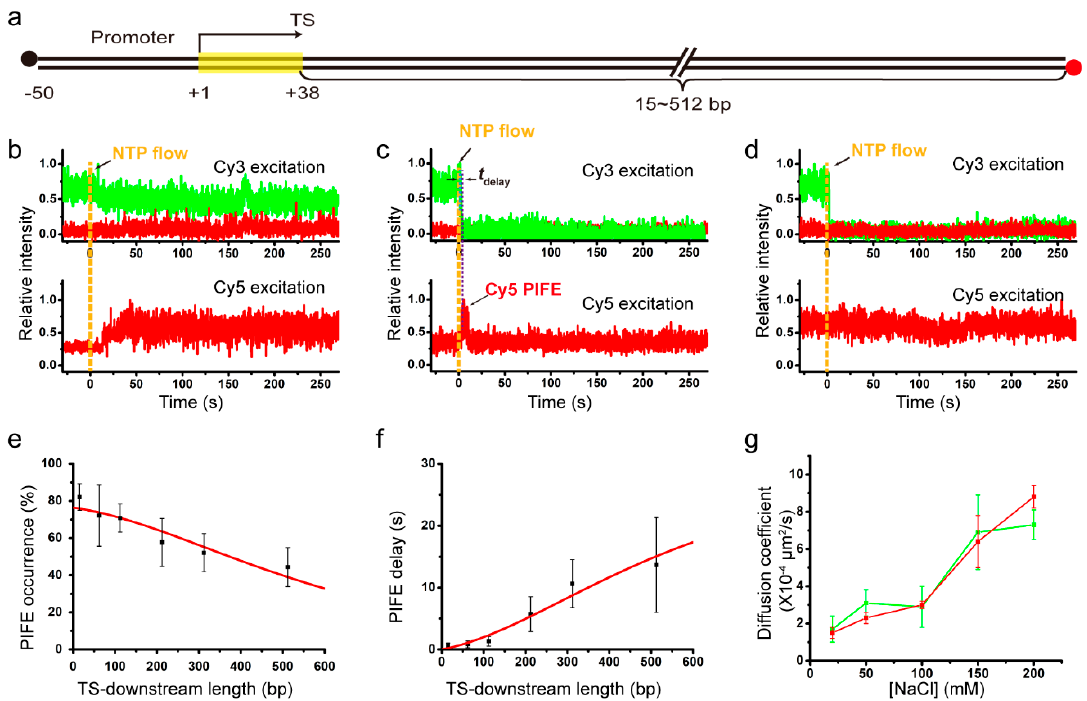
Figure 2. ( a ) DNA with varying length of TS-downstream part. Template DNAs were labeled with Cy5 at the downstream end and immobilized using biotin (black) at the upstream end. Transcript RNAs were nascently labeled with Cy3 at the 5’ end. ( b – d ) Representative fluorescence traces were taken from complexes with DNA template L+212. The Cy3 (green) and Cy5 (red) signals were obtained from Cy3 (top) and Cy5 (bottom) excitations on individual complexes of readthrough at TS ( b ), termination at TS with subsequent Cy5 PIFE ( c ), and termination at TS without Cy5 PIFE ( d ). Yellow vertical lines indicate NTP injection timing. PIFE delay ( t delay ) in ( c ) is the time difference between Cy3 vanishing and Cy5 PIFE starting. ( e ) PIFE occurrences plotted against TS-downstream lengths from the experiments with 150 mM NaCl. The occurrence data (black squares) fit to a 1D diffusion model (red line). ( f ) PIFE delays plotted against TS-downstream lengths from the 150 mM NaCl experiments. The delay data (black squares) fit to a 1D diffusion model (red line). ( g ) The 1D diffusion coefficients estimated using the PIFE occurrence data (red) and PIFE delay data (green) are plotted against NaCl